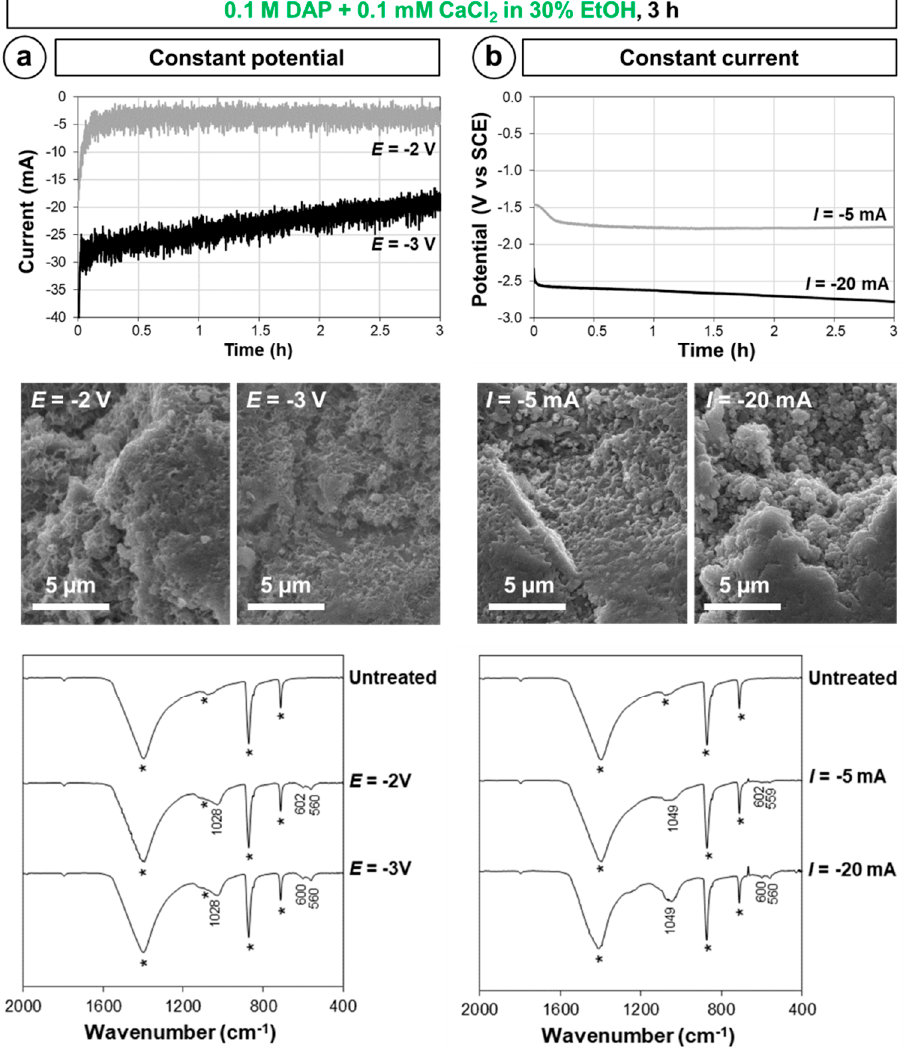
Figure 5. Electrokinetic parameters measured during electrodeposition, morphology, and composition of the new phases formed in ( a ) potentiostatic and ( b ) galvanostatic conditions (in the FT-IR spectra, bands owing to the substrate are marked by a star, while the position of the new bands owing to CaP phases is reported).